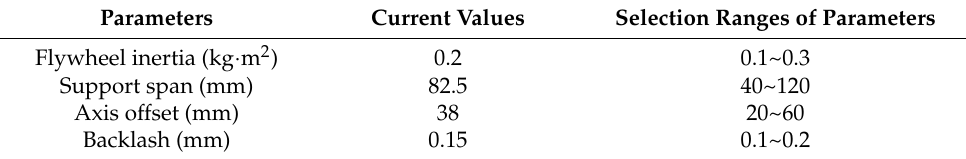
Table 5. Ranges of parameters.